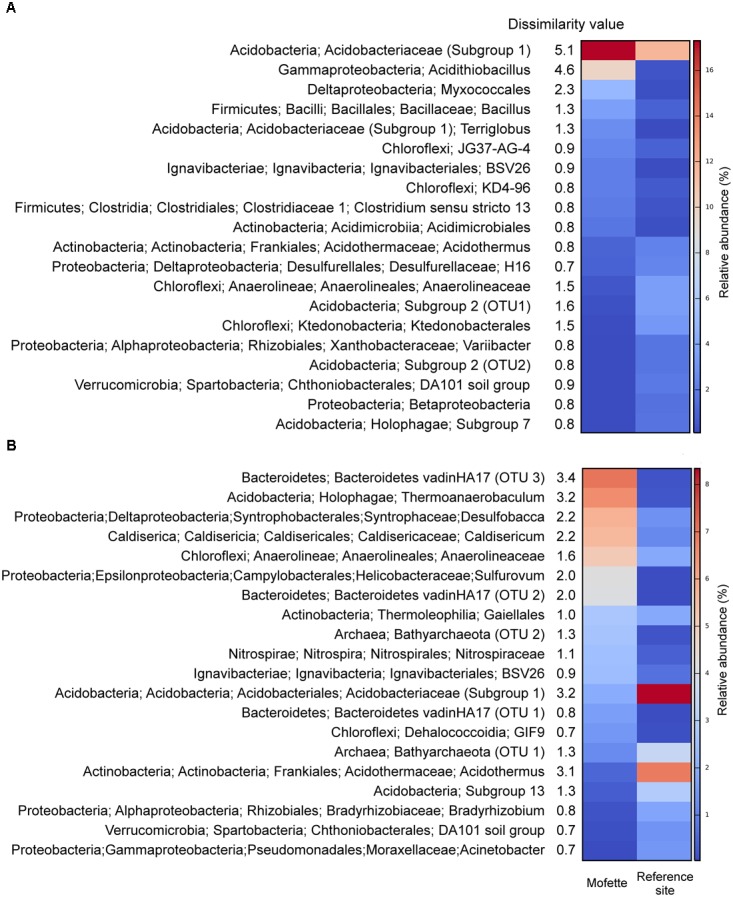
Heatmap of the top 20 taxa which explain most of the dissimilarity between the microbial communities of the mofette and the reference site based on the Bray–Curtis dissimilarity values. Cluster A (depths between 0 and 95 cm) (A) and Cluster B (depths between 100 and 275 cm) (B).